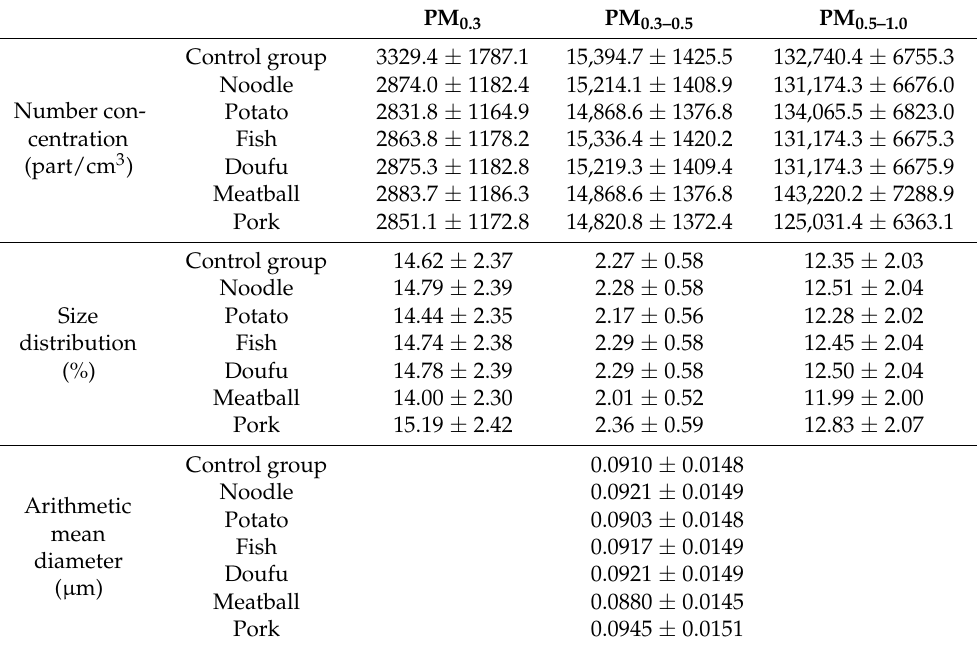
Table 3. The amplitude of particles emitted by boiling food (Mean ±